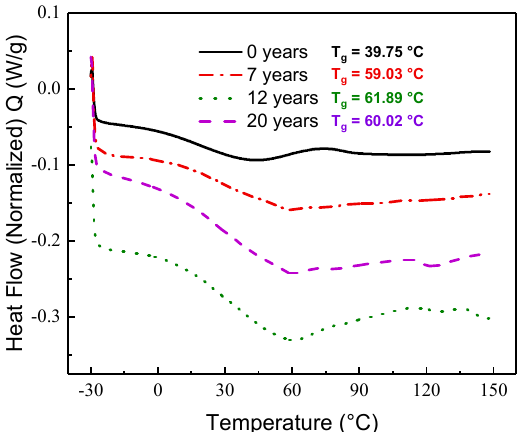
Figure 22. DSC analysis of epoxy coatings under different durations of exposure.